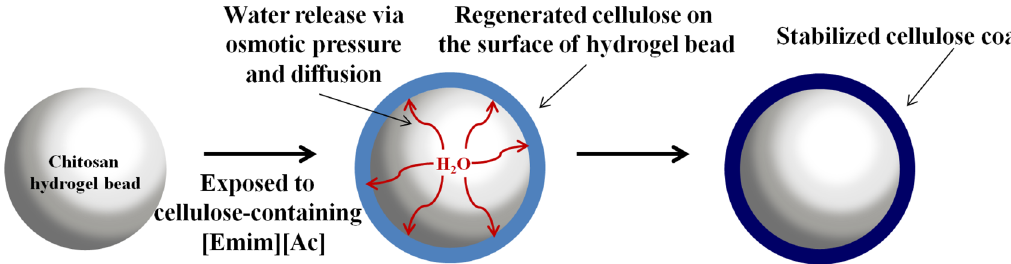
Figure 1. Schematic presentation of cellulose coating principle.